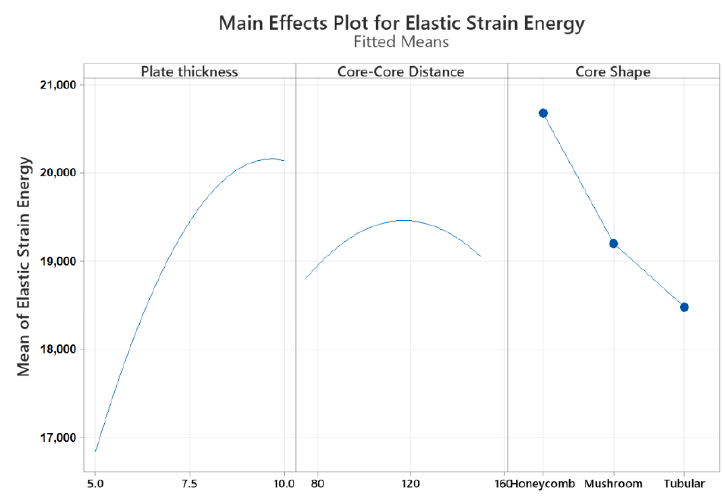
Figure 26. Main effects plot for elastic strain energy.